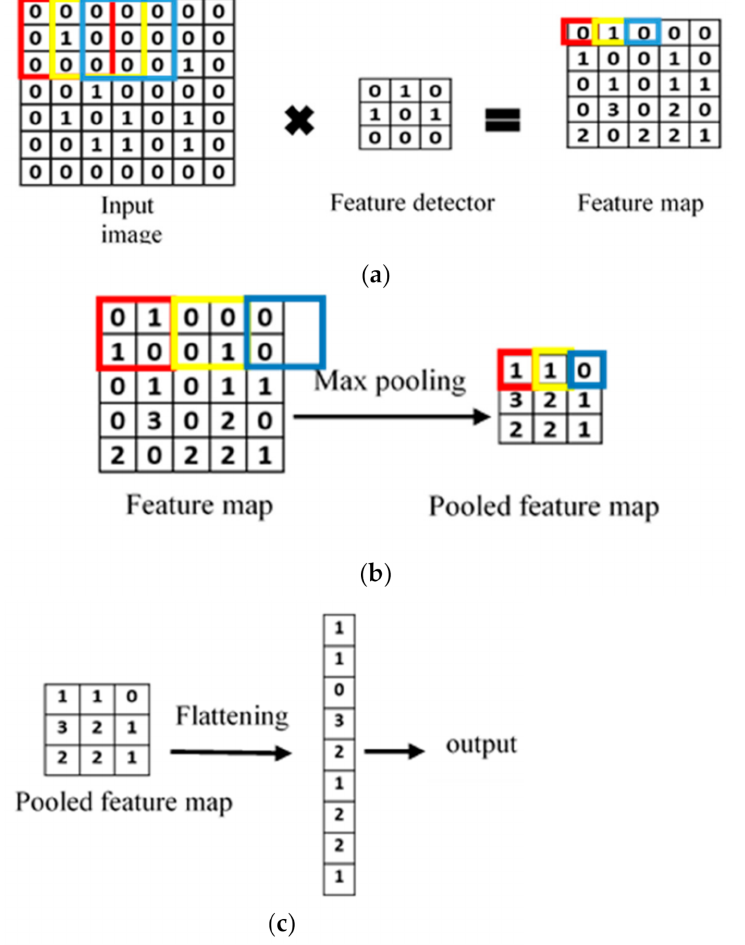
Figure 4. CNN structure ( a ) Convolutional layer; ( b ) Pooling layer; ( c ) Fully connected